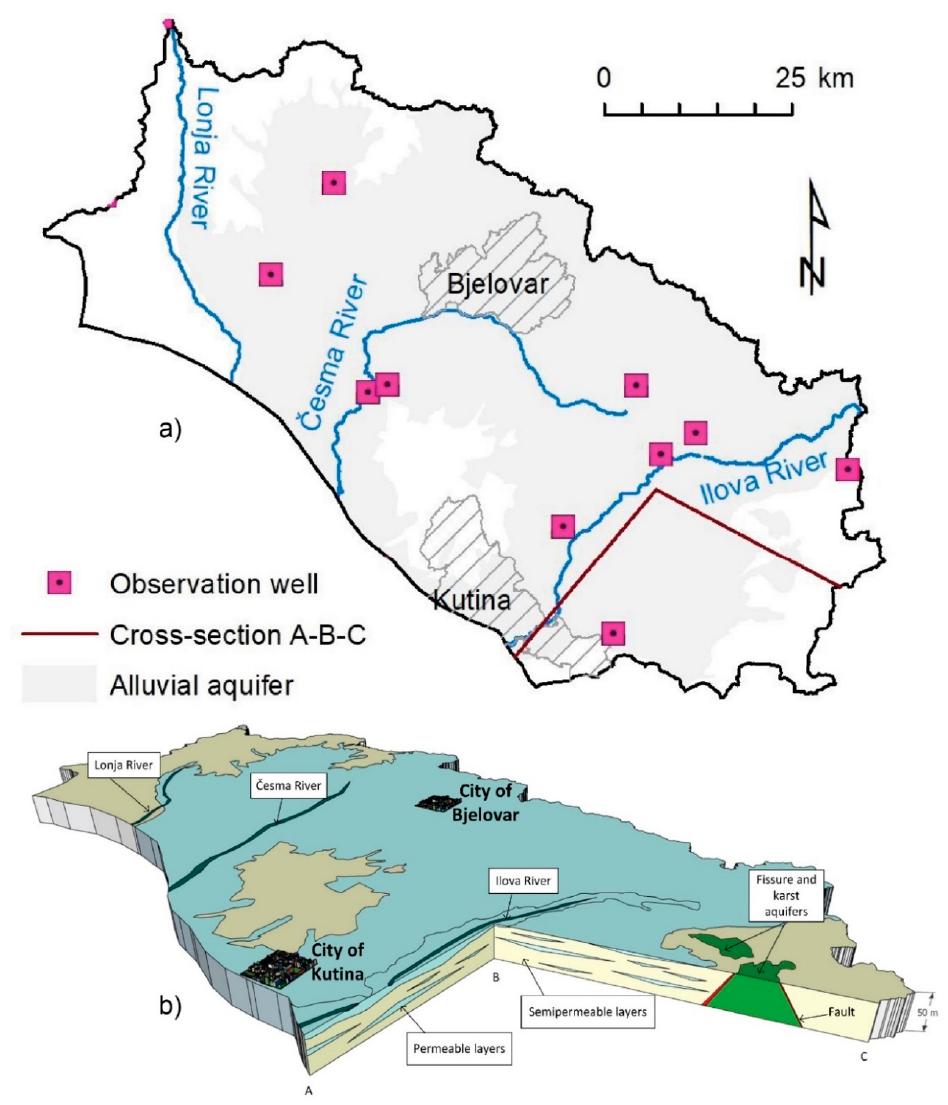
Figure 5. Conceptual model of the groundwater body CSGN_25: ( a ) Planar extent of the groundwater body; ( b ) Schematic 3D hydrogeological cross-section.